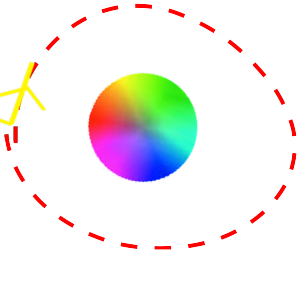
Figure 13. The colormap and the flight